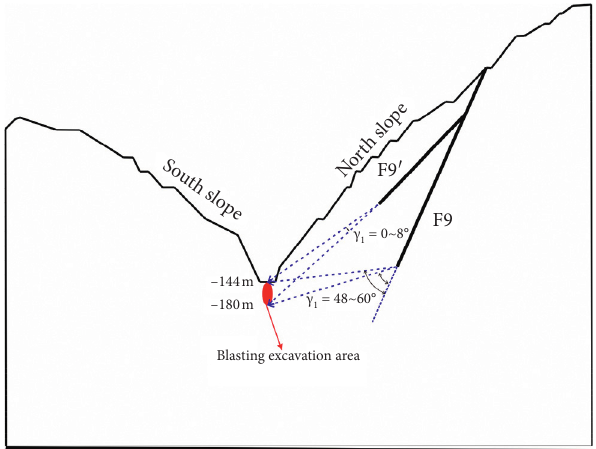
Figure 3: Profit of engineering geological conditions of Daye iron mine.